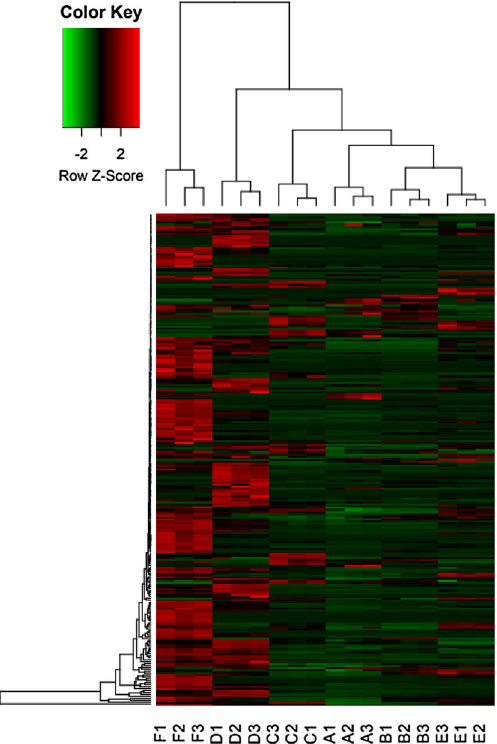
Figure 8. Hierarchical cluster analysis: heat-map reflecting the differences between compounds revealed in the (SPME) GC–MS analysis of volatiles compounds. Capital letters indicates the sample and the number the analytical repetition. Heat-map was generated using R 3.5.2. software 30